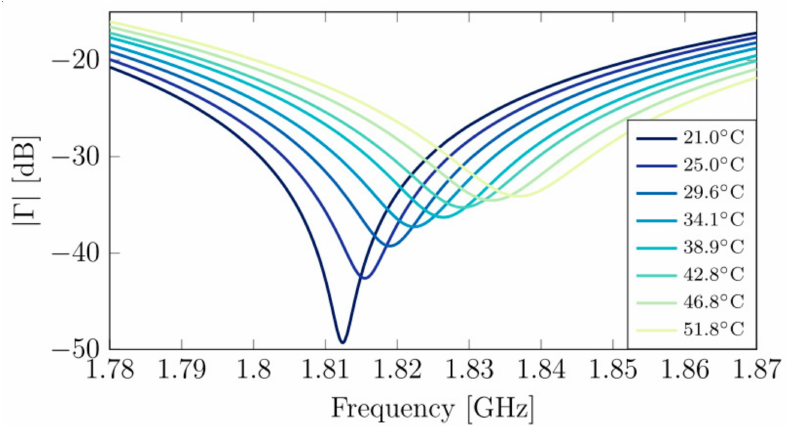
Figure 15. The results of reflection coefficient measurements for the different temperature water samples [99]. Reprinted from Maenhout, G.; Markovic, T.; Bao, J.; Stefanidis, G.; Ocket, I.; Nauwelaers, B. Dielectric-based temperature sensing of nanoliter water samples with a post-processing tuned matching network. Meas. Sci. Technol. 2020 , 31 , doi:10.1088/1361-6501/ab9937 with permission from IOP Publishing